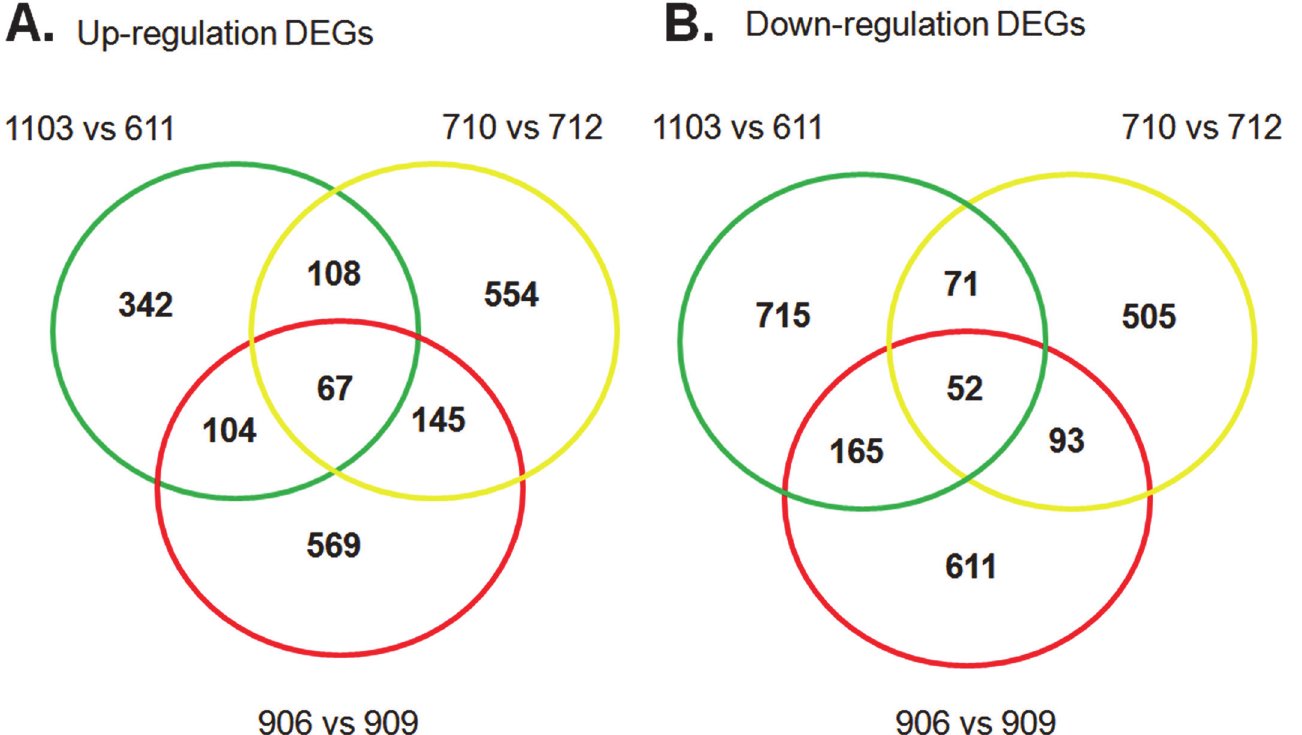
Fig 4. Venn diagrams showing differentially expressed genes (DEGs) among each of three pairs. A. Up-regulated genes in BH compared with BL in three pairs. B. Down-regulated genes in BH compared with BL in three pairs.